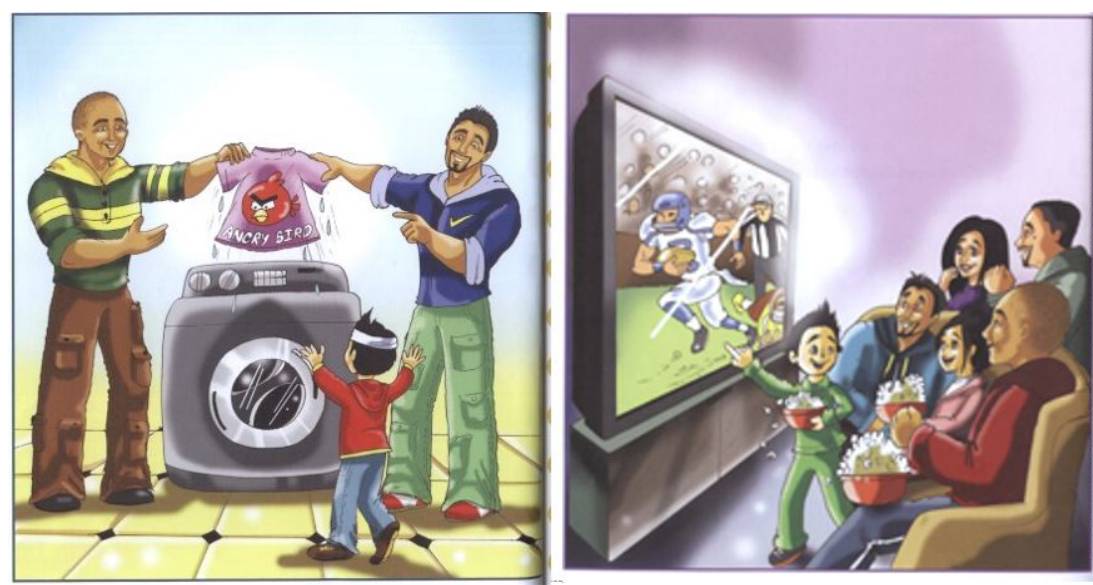
Figure 11. My Two Uncles & Me emphasizes a passion for football .